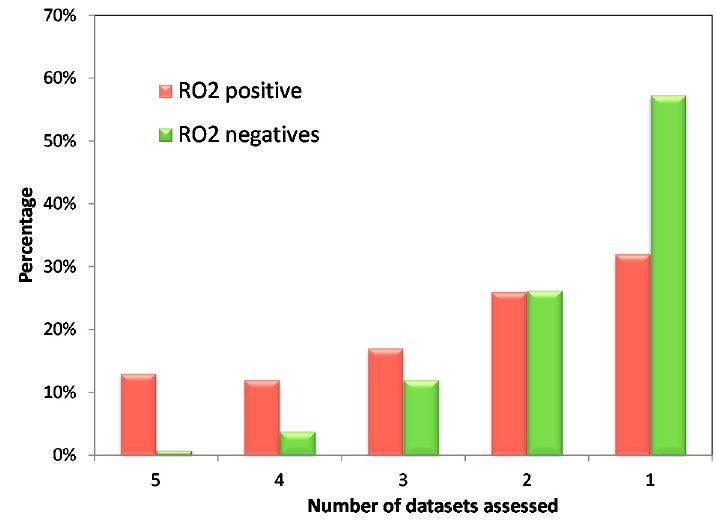
Figure 2. The overlap of Rule of Two (RO2) positives and negatives across the five investigated datasets. From the left to the right: Red bars depict drugs that are RO2 positives and the percentage of RO2 positives that were identified as hepatotoxic among all datasets ( left ) to only one dataset ( right ). Green bars depict drugs that are RO2 negatives and the percentage of RO2 negatives are in agreement with all five datasets ( left ) to only one dataset ( right ). To calculate the overlap of RO2 positives and negatives across the investigated datasets, a total of n = 763 drugs were considered, of which n = 139 were RO2 positives and n = 624 were RO2 negatives. The percentage of RO2 positives shared by all five datasets is much higher than the percentage of RO2 negatives. Importantly, the percent of RO2 negatives sharply decreases as the number of datasets increases, indicating a lack of consensus in the DILI classifications of RO2 negatives as compared to that of RO2 positives. Table 1. The assessment of the relationship between DILI risk, lipophilicity, and daily dose.